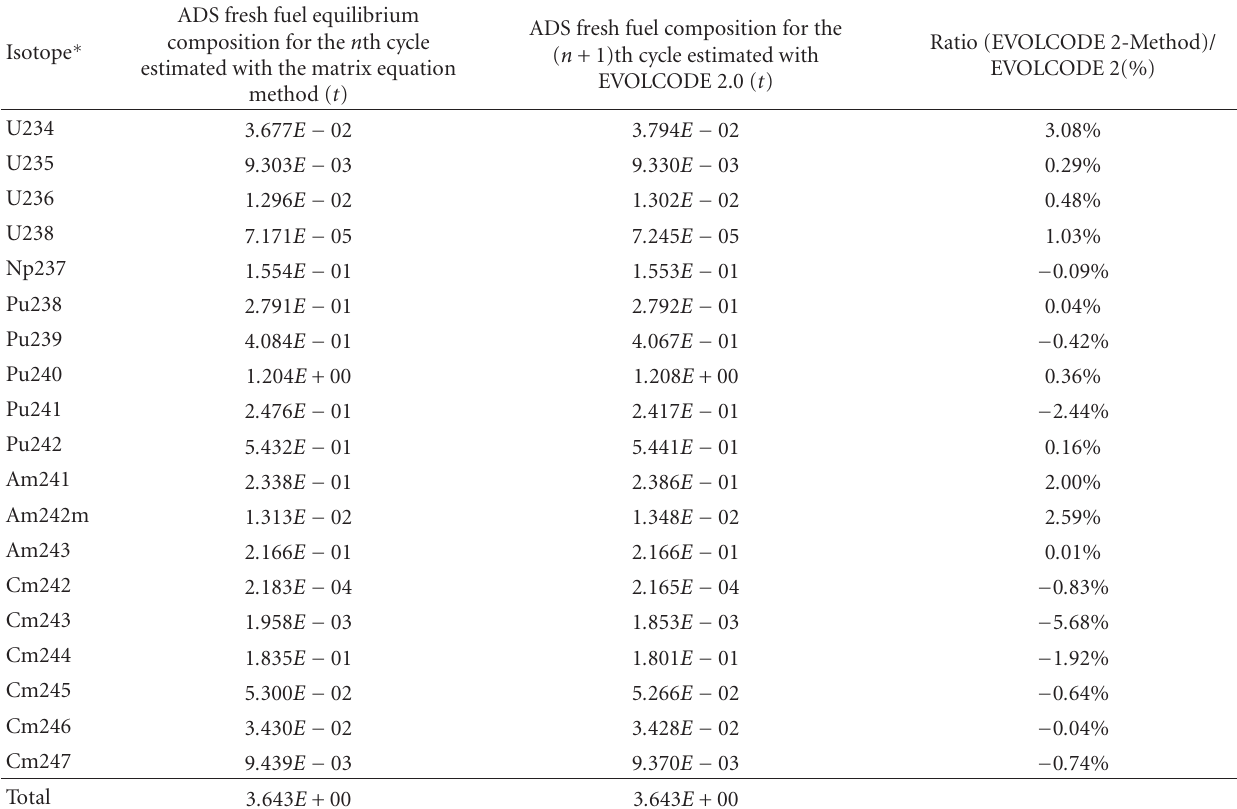
Table 1: Equilibrium isotopic composition of the ADS fuel, before the irradiation, for cycles n and ( n + 1). Units are tonnes of initial heavy metal in the ADS. ADS fresh fuel equilibrium ADS fresh fuel composition for the composition for the n th cycle Isotope ∗ ( n + 1)th cycle estimated estimated with the matrix equation method ( t )